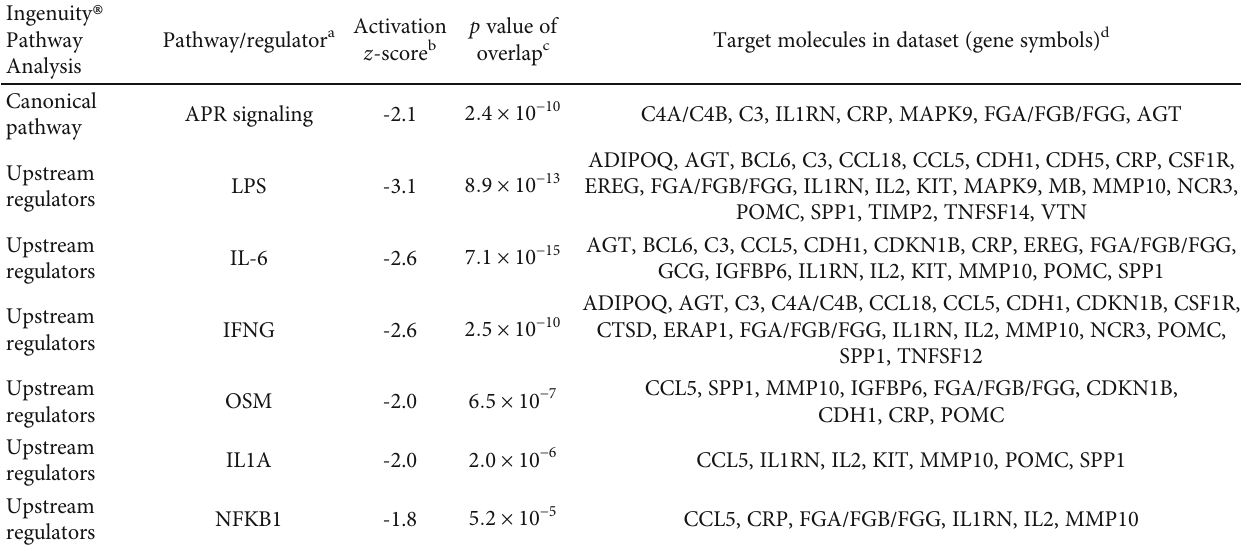
Table 1: Apabetalone downregulates transcriptional targets of in fl ammatory mediators in the CAD patient plasma as predicted by IPA® “ canonical pathway ” and “ upstream regulators ” analysis.